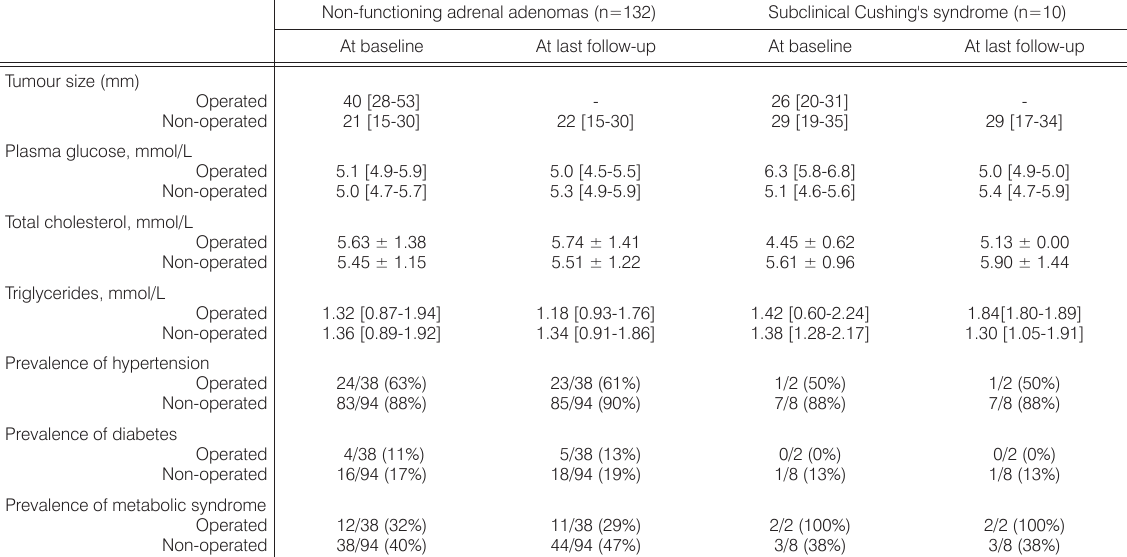
Table 4. Characteristics of followed-up patients with non-functioning adrenal adenomas and subclinical Cushing's